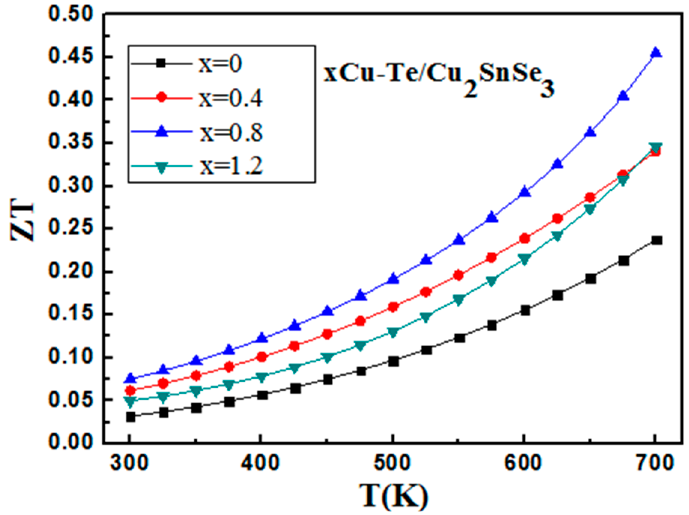
Figure 10. The dimensionless figure of merit of ( ZT ) of Cu–Te/Cu 2 SnSe 3 composites.